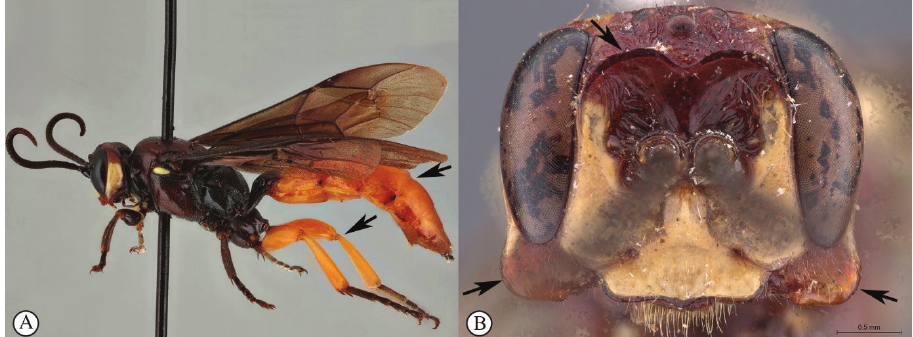
8 Metasoma, hind femora and tibiae yellowish-orange (A); frons with a broad cordate lamella above the antennal scrobes (B) ............................................